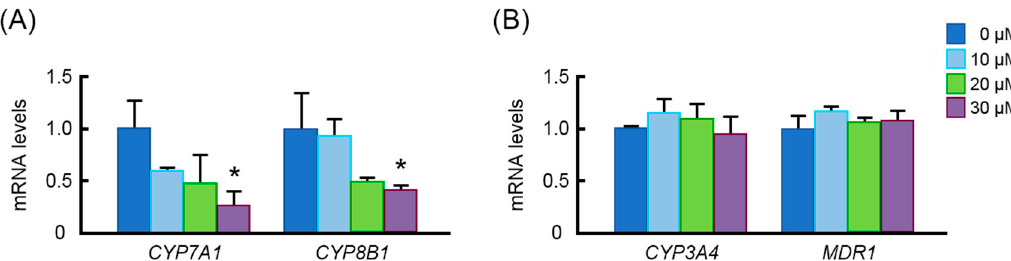
Figure 6. Effects of menaquinone-4 on gene expression in human hepatocarcinoma HepG2 cells. HepG2 cells were treated with menaquinone-4 for 24 h, and then mRNA levels of CYP7A1 and CYP8B1 ( A ) and CYP3A4 and MDR1 ( B ) were measured by quantitative RT-PCR. The relative mRNA levels were normalized to the amount of eukaryotic translation elongation factor 1 α 1 mRNA. Data are expressed as the mean ± SEM, n = 3. * p < 0.05, compared to control.